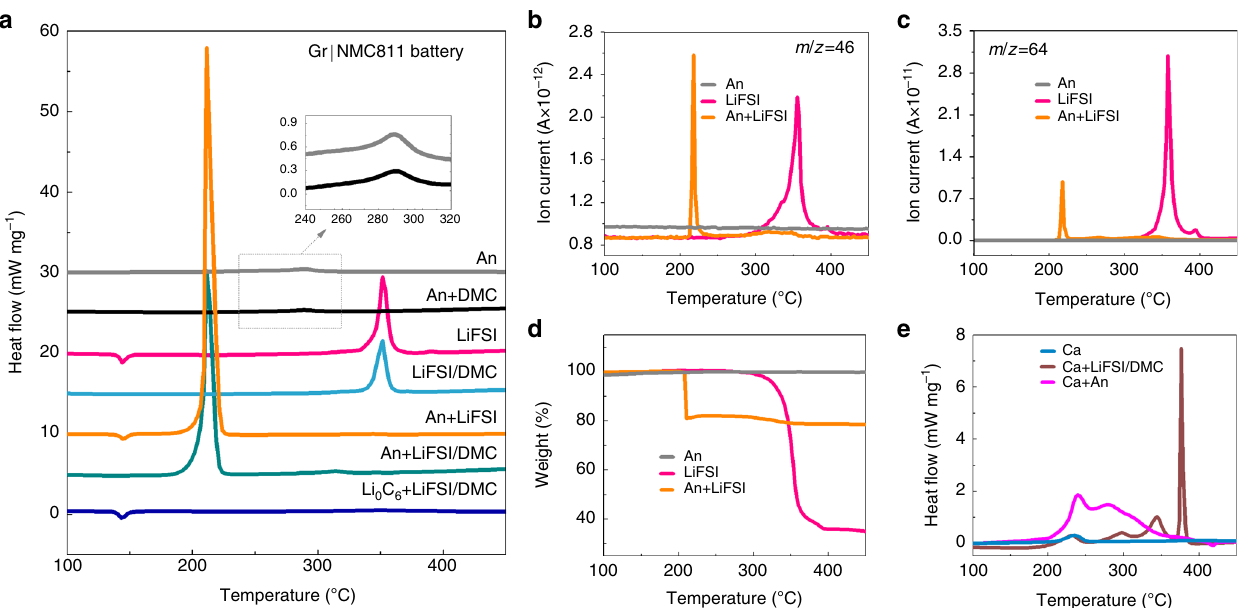
Fig. 4 Thermal stability of cell components and their mixtures in the Gr|NMC811 battery. a DSC traces of the lithiated anode, concentrated LiFSI/DMC electrolyte components, and their mixtures for the Gr|NMC811 battery. The inset displays the enlarged peaks of An and An + DMC. b NO 2 ( m / z = 46) gas evolution of LiFSI, the lithiated anode and their mixture during the DSC measurement. c SO 2 ( m / z = 64) gas evolution of LiFSI, the lithiated anode, and their mixture during the DSC measurement. d The weight loss of the lithiated anode, LiFSI, and their mixture. e DSC traces of the cathode, cathode mixed with concentrated LiFSI/DMC, and cathode mixed with